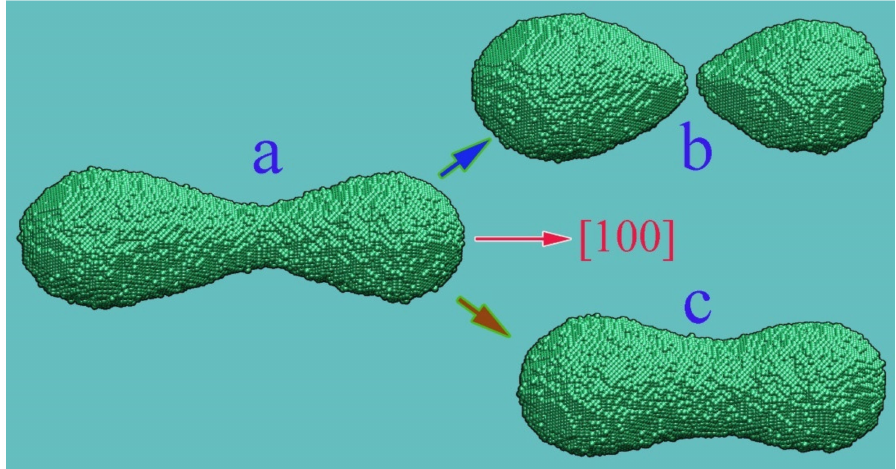
Figure 4. Controlling the direction of surface atomic flows in the nanocluster-narrowing region. Configuration ( b ) is formed from the initial state ( a ) as a result of the outflow of atoms from the narrowing area in the case of a low surface diffusion rate— p = 0.7, α = 1. When surface diffusion is stimulated, p = 0.825, α = 1, the influx of atoms into this zone forms the entire cluster ( c ). The presented two-way transformation is stably reproduced in other random realizations of the dynamics of the initial